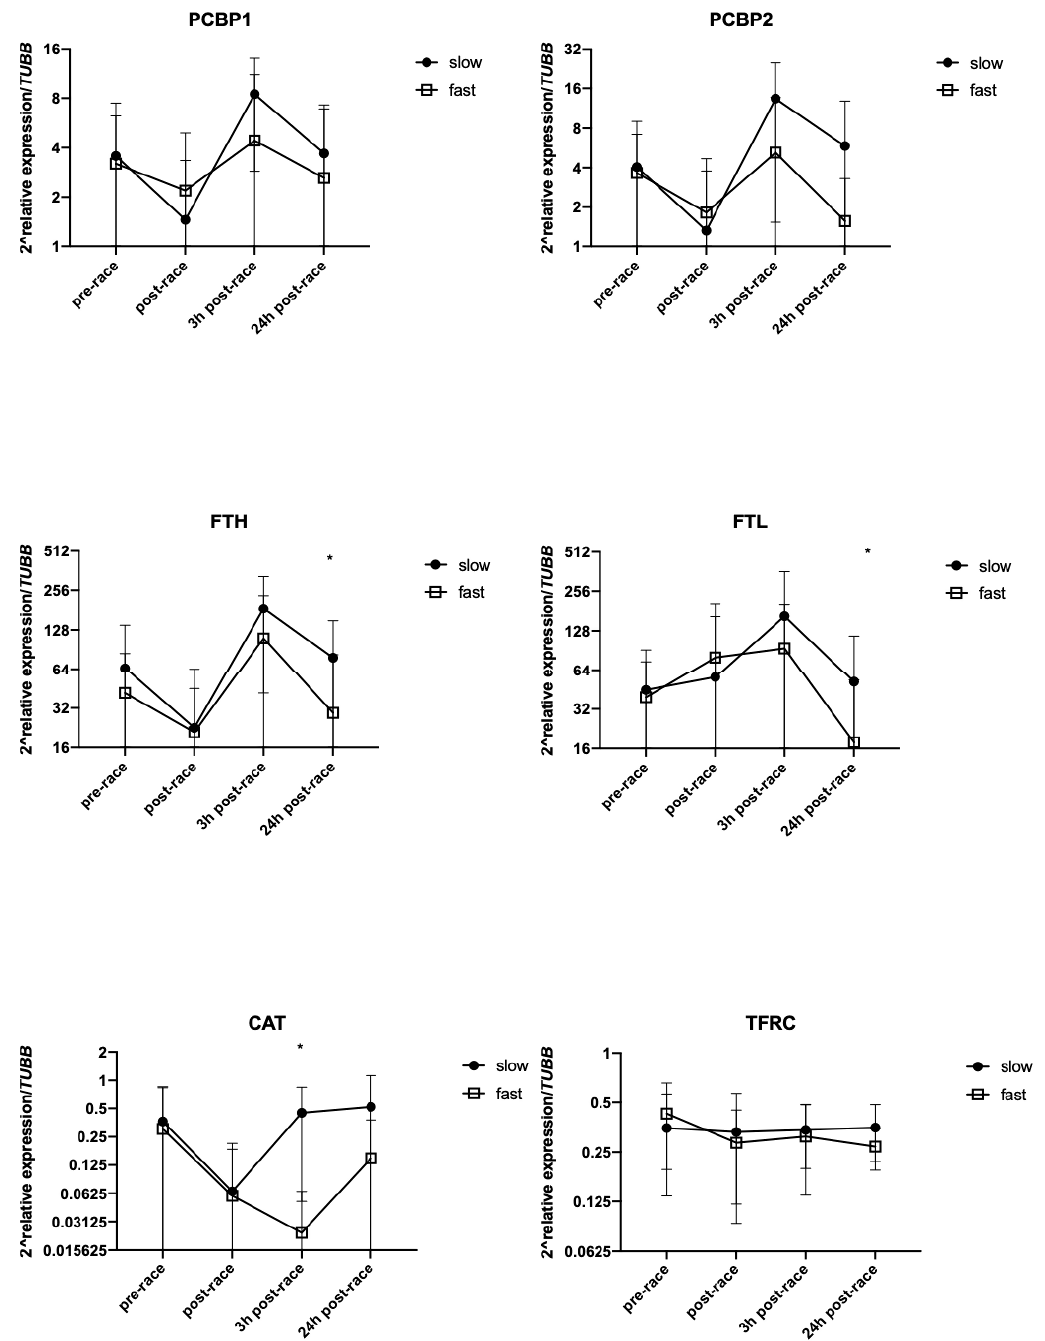
Figure 3. Changes in mRNA levels between slow and fast runners ( n = 12 per group). Values are mean ± SD. * p < 0.05 for comparison between two groups.